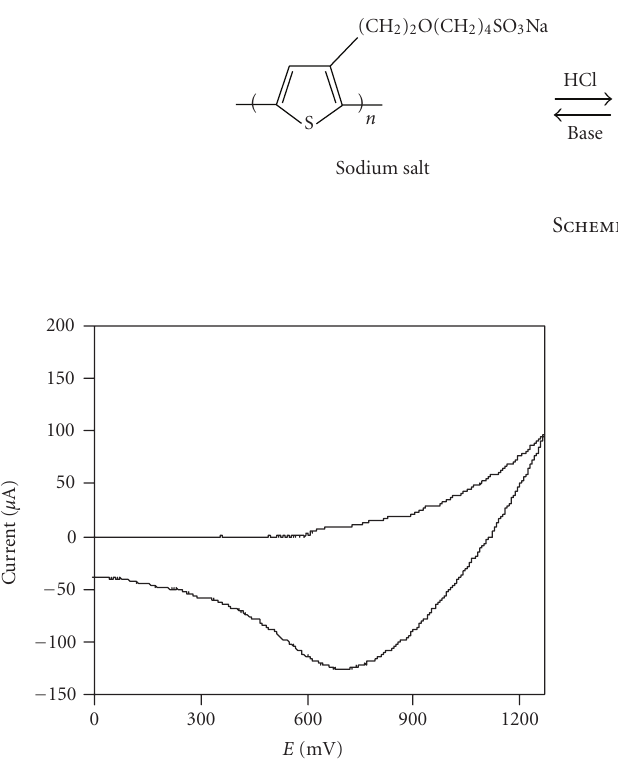
Figure 4: Cyclic voltammogram of PTEBS polymer.